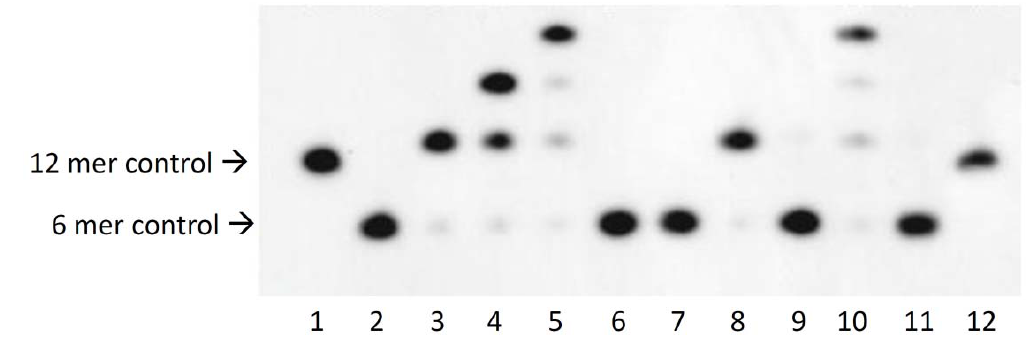
Figure 2. Autoradiogram of a denaturing polyacrylamide gel electrophoresis of photoreaction of ODN 1, ODN 2, ODN 3, ODN 4 and template 1 was annealed and photoirradiated at 366 nm for 8 h at 4 °C. Lane 1, 12-mer control; lane 2, 6-mer control; lane 3, ODN 1 + ODN 2 + template 1 + 366 nm; lane 4, lane 3 + ODN 3; lane 5, Lane 4+ ODN 4; lane 6, lane 5 without 366 nm; lane 7, lane 5 without ODN 2; lane 8, lane 5 without ODN 3; lane 9, lane 5 without template 1; lane 10, lane 5; lane 11, lane 10 + 312